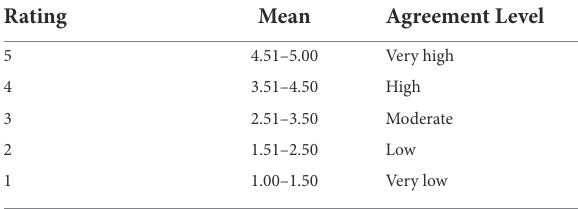
TABLE 1 Five-point Likert scale agreement level (Adapted from Altan,